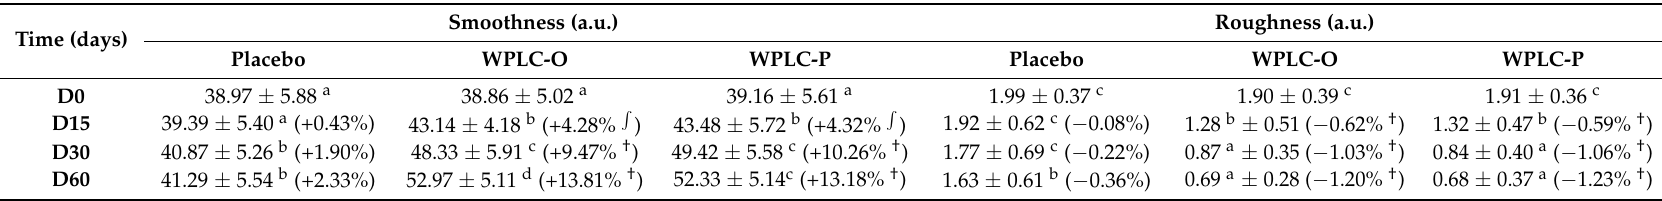
Table 8. Skin smoothness and roughness values after 15, 30 and 60 days of supplementation with WPLC-O and WPLC-P extracts. Data are averages ± SD in SESm (a.u.) and SEr (a.u.)